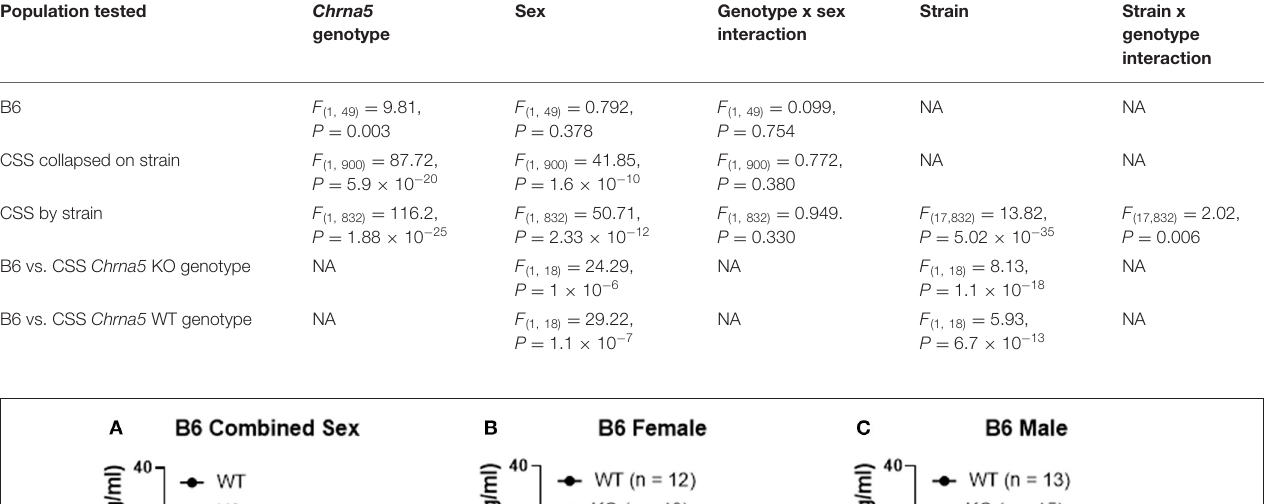
TABLE 1 | Statistics for population comparisons.